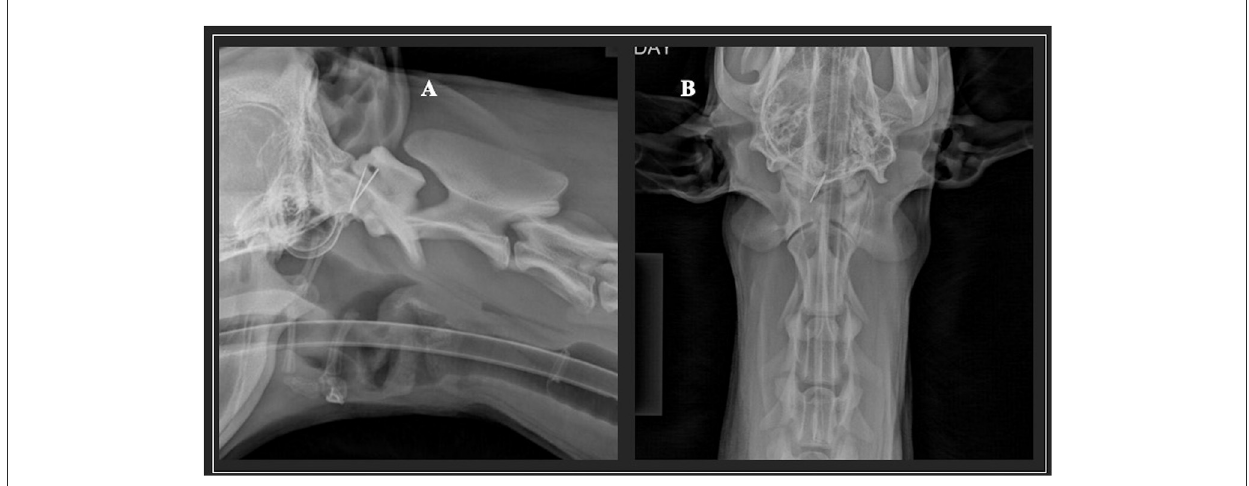
FIGURE1 Lateral (A) and ventrodorsal (B) radiographs of a nine-month-old female German Shepherd was presented as an emergency for evaluation of a progressive, right asymmetrical, non-ambulatory tetraparesis and cervical pain. The metallic foreign bodies are very evident.